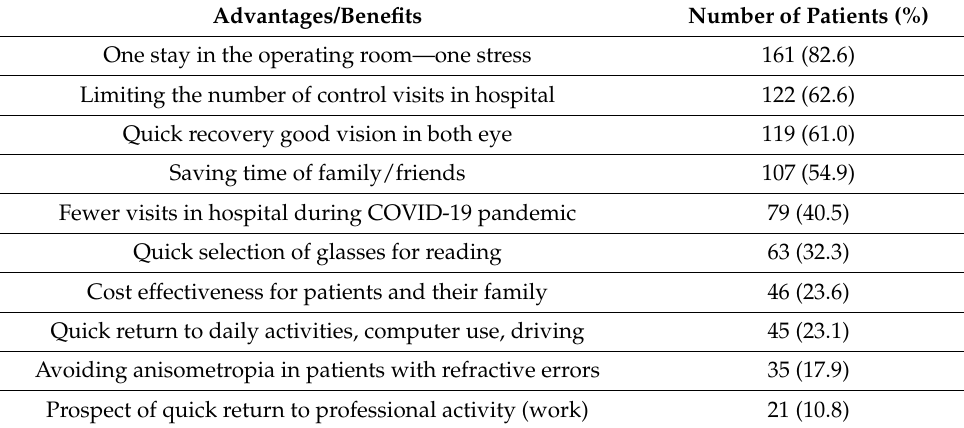
Table 4. Patients’ opinions about the advantages and benefits of immediate sequential bilateral cataract surgery (listed by